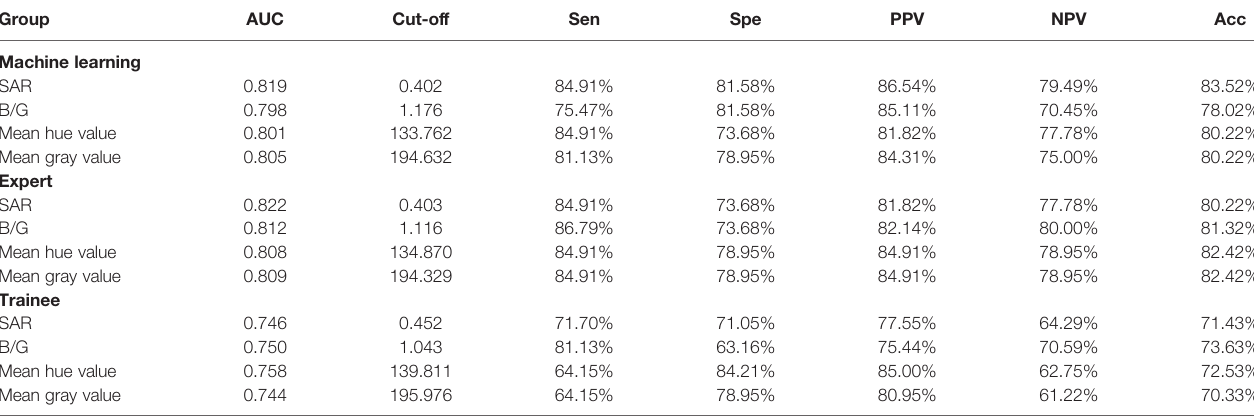
SAR, stiff area ratio; B/G, elasticity ratio of blue/green; AUC, area under curve; Sen, sensitivity; Spe, speci fi city; PPV, positive predictive value; NPV, negative predictive value; Acc, algorithm to EBUS strain elastography, we realized the automatic selection of high-quality and stable images from strain